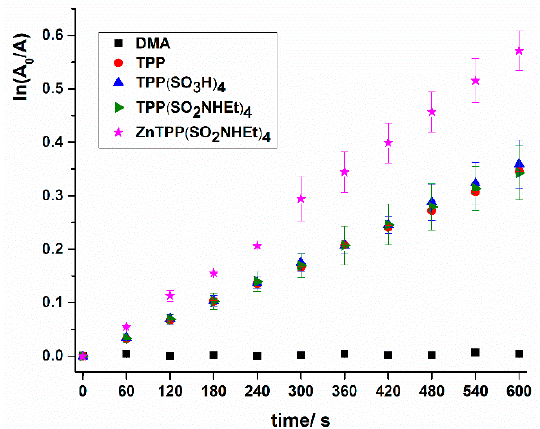
Figure 3. Photo-oxidation of DMA, in DMF, photosensitized by TPP (used as reference), TPP(SO 3 H) 4 , TPP(SO 2 NHEt) 4 , and ZnTPP(SO 2 NHEt) 4 during 600 s at 420 nm ± 5 nm. The symbols may be overlapped. DMA (black squares) is a solution of DMA irradiated without the addition of any PS in order to assure that no photodegradation